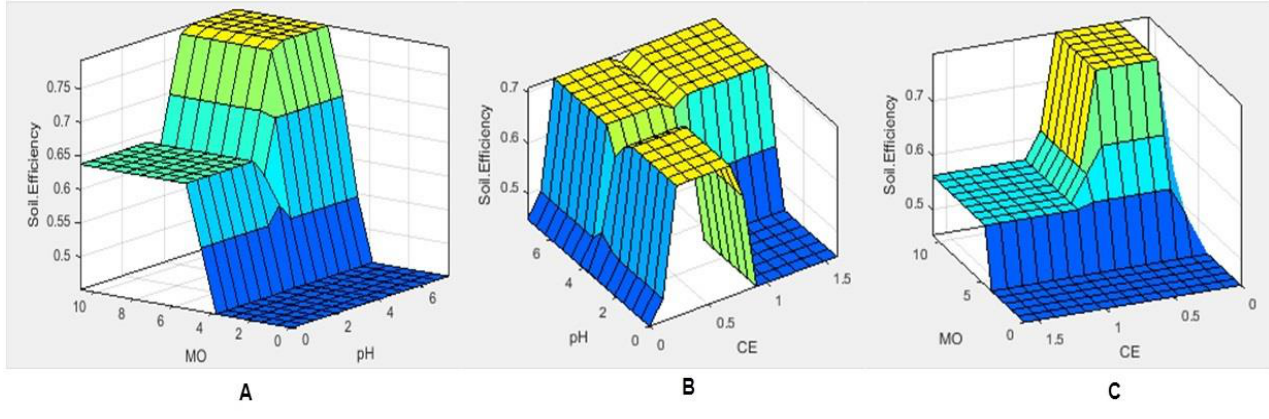
Figure 12. Impact of input variables in reactive agent model .